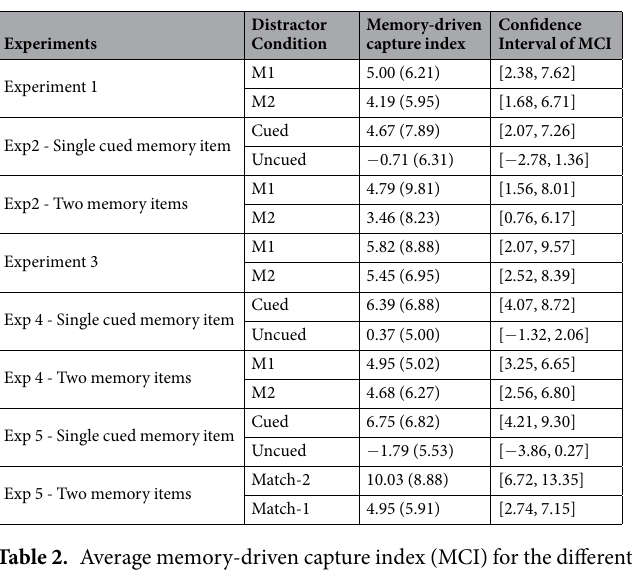
Table 2. Average memory-driven capture index (MCI) for the different distractor conditions in Experiments 1–5. Data between parentheses represents SDs. MCI = (RTcue-RTnew)/0.5 * (RTcue + RTnew).